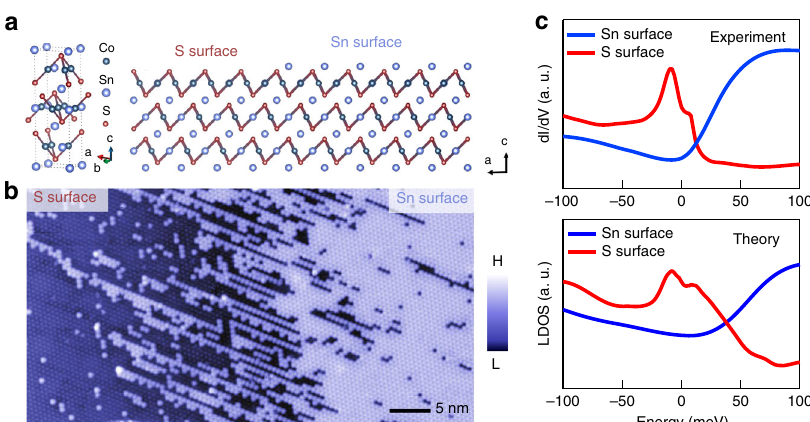
Fig. 4 Extended evidence for surface identi fi cation in Co 3 Sn 2 S 2 . a Crystal structure of Co 3 Sn 2 S 2 (left) and the cleaving surface illustration (right). b Atomically resolved topographic image of the boundary between S surface and Sn surface. The S surface smoothly evolves into the Sn surface with increasing coverage of Sn adatom. c Comparison between spatially averaged surface dependent dI/dV curves with the fi